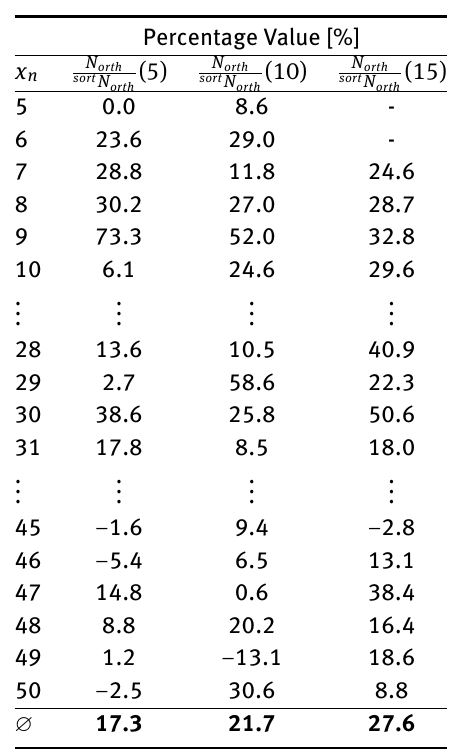
Figure 4: Average number of N orth and sort N orth Table 2: Percentage Value of N orth sort N